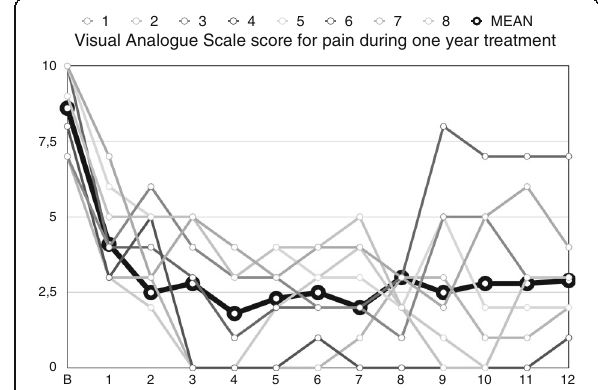
Fig. 1 Mean Visual Analog Scale scores per month for eight patients during the first year of treatment. Bold line represents the men of eight